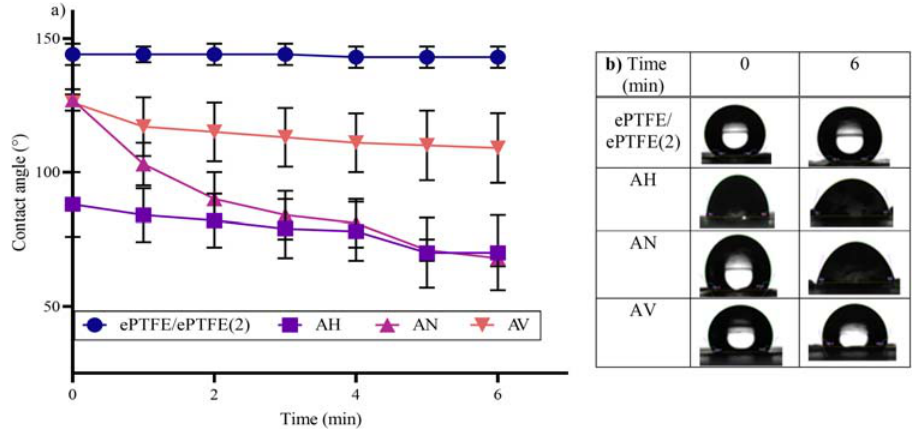
Figure 2: ( a ) Graph of contact angle for unmodi fi ed and modi fi ed ePTFE and ( b ) image of contact angle for unmodi fi ed and modi fi ed